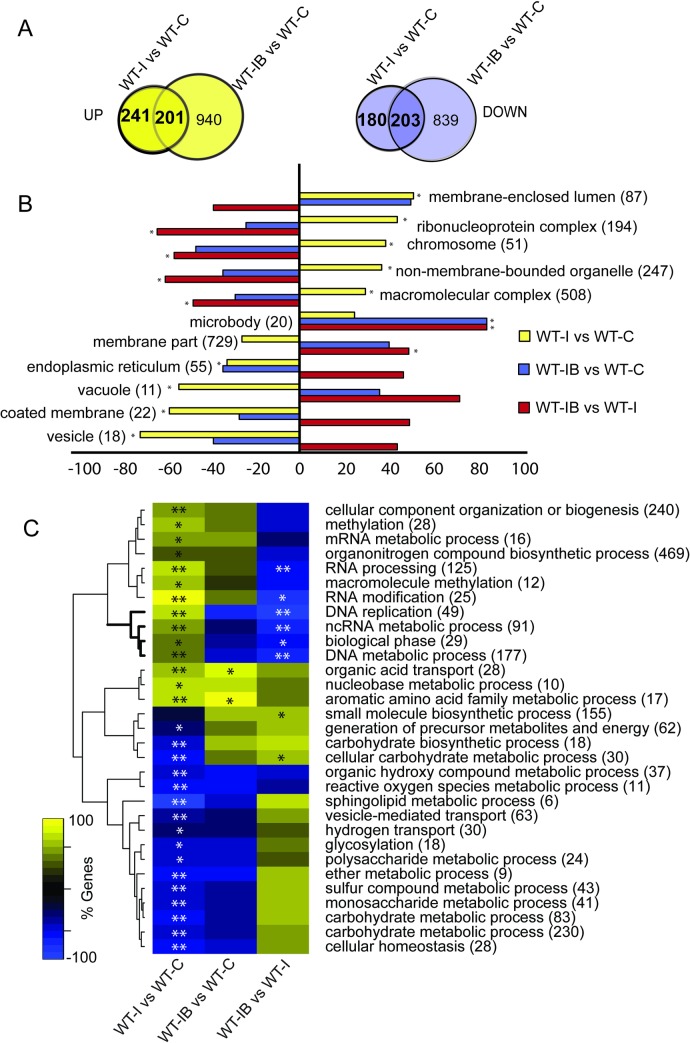
Calcium is essential for the transcriptional response to injury.A. Venn diagrams show the overlap of the induced (yellow) and repressed (purple) genes of the WT strain in response to injury (WT-I) and in response to injury after BAPTA treatment (WT-IB), as compared to an untreated control (WT-C). B. Enrichment analysis using Cellular Component Gene Ontology (GO) terms, showing the percentage of induced or repressed genes belonging to each category (FDR <0.05*). C. Clustering of significantly enriched Biological Process GO terms, showing the percentage of induced or repressed genes belonging to each category (FDR <0.01**; FDR <0.05*). In B and C, the sign indicates the direction of change, positive/negative being higher/lower in injury than in the control. The number in parenthesis after each GO term indicates the total number of genes in that category.